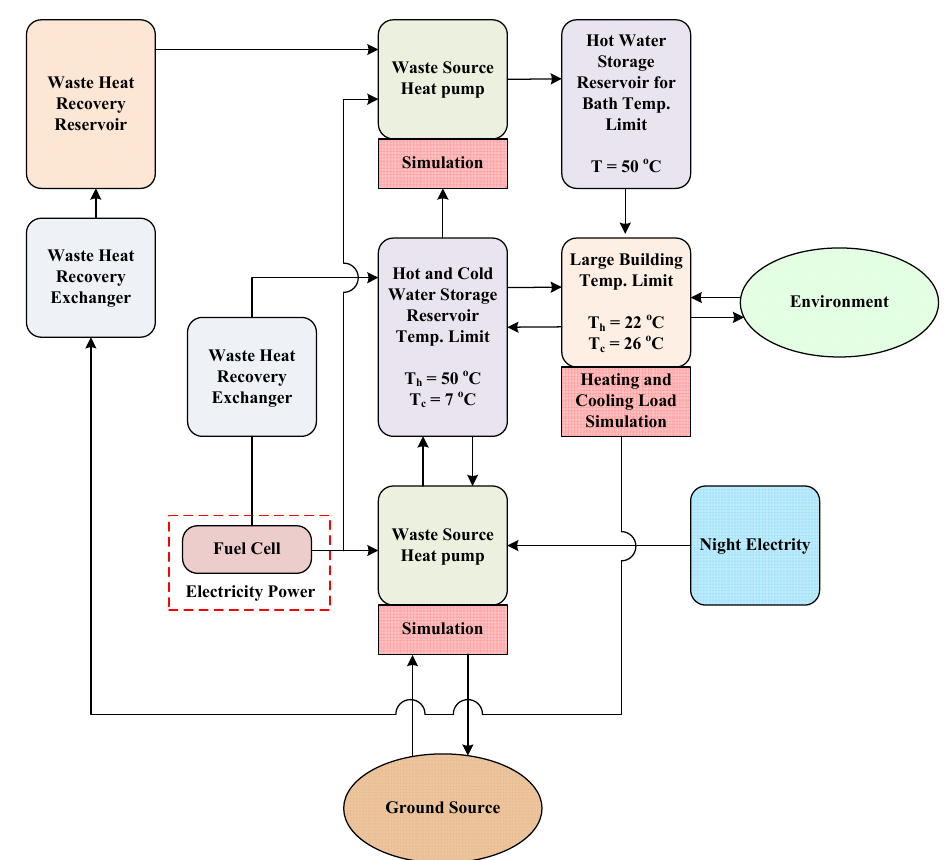
Figure 1. Schematic diagram of the fuel cell driven ground source heat pump heating and cooling